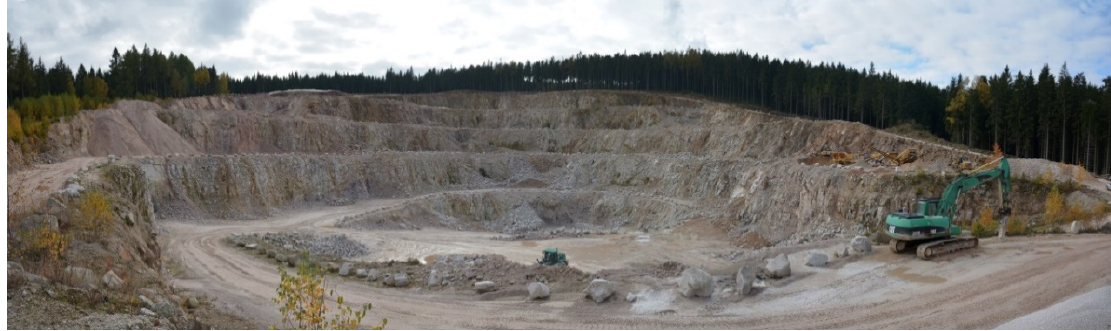
Figure 5. Krásno-Vysoký Kámen feldspar deposit: the most important magmatic deposit in the Figure 5. Kr á sno-Vysok ý K á men feldspar deposit: the most important magmatic deposit in the Czech Czech Republic. Photo: Jaromír Starý, 2016. Republic. Photo: Jarom í r Star ý ,